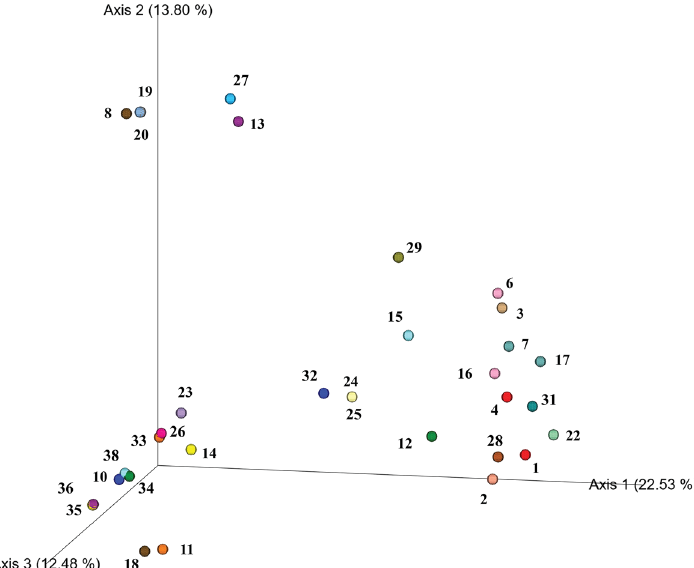
Figure 3. Herbal samples were grouped using principal component analysis (PCA). Each number represents a sample.